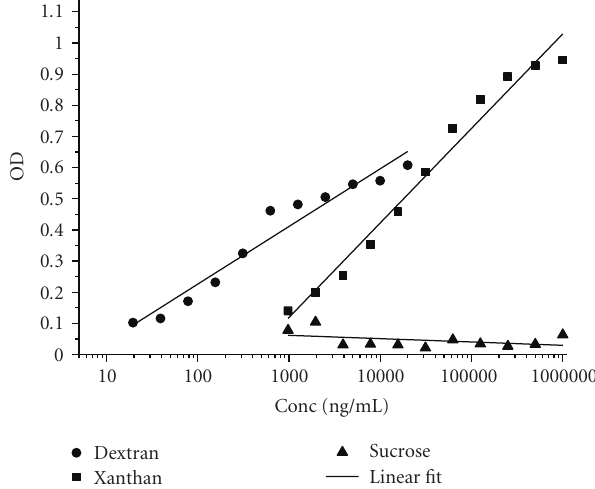
Figure 1: Lectin assay: standard carbohydrate calibration curves of • dextran, (cid:2) xanthan, (cid:2) sucrose, and regression lines as linear fit.